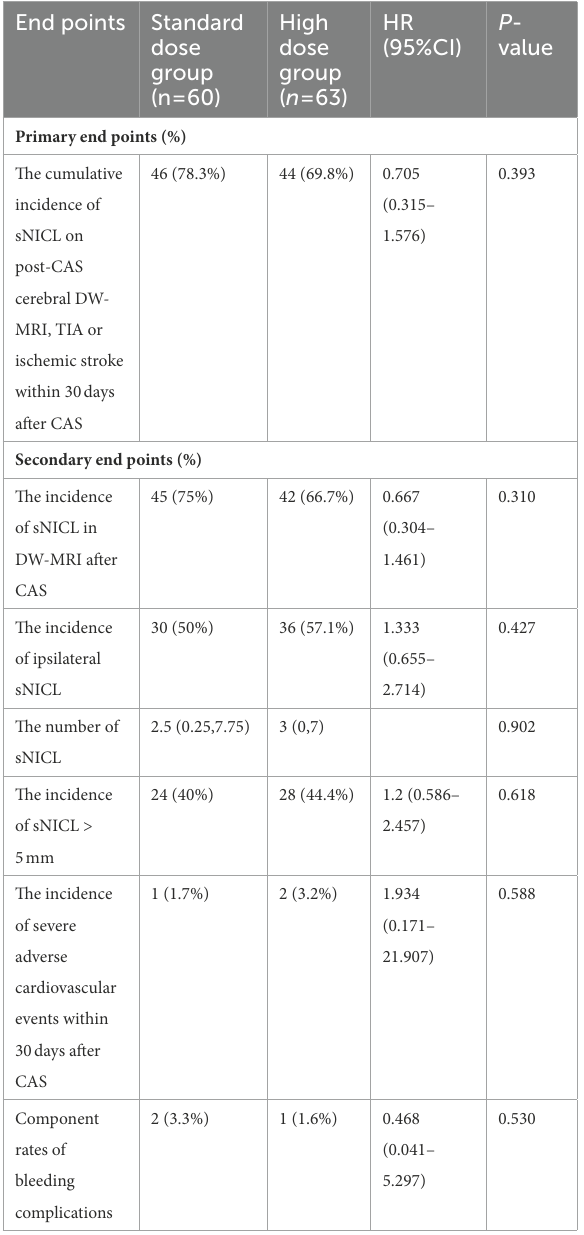
TABLE 2 Hazard ratios for clinical end